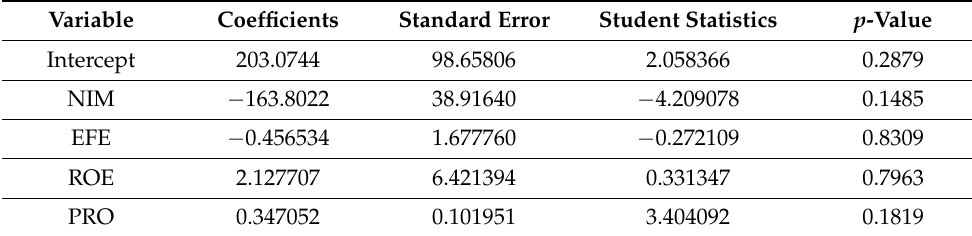
Table 14. Results of regression analysis.